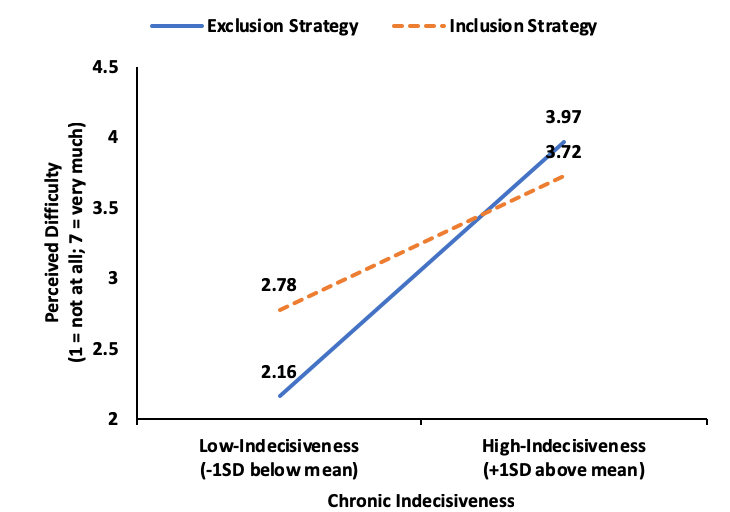
<Figure 4> Study 2: Perceived Difficulty (Spotlight